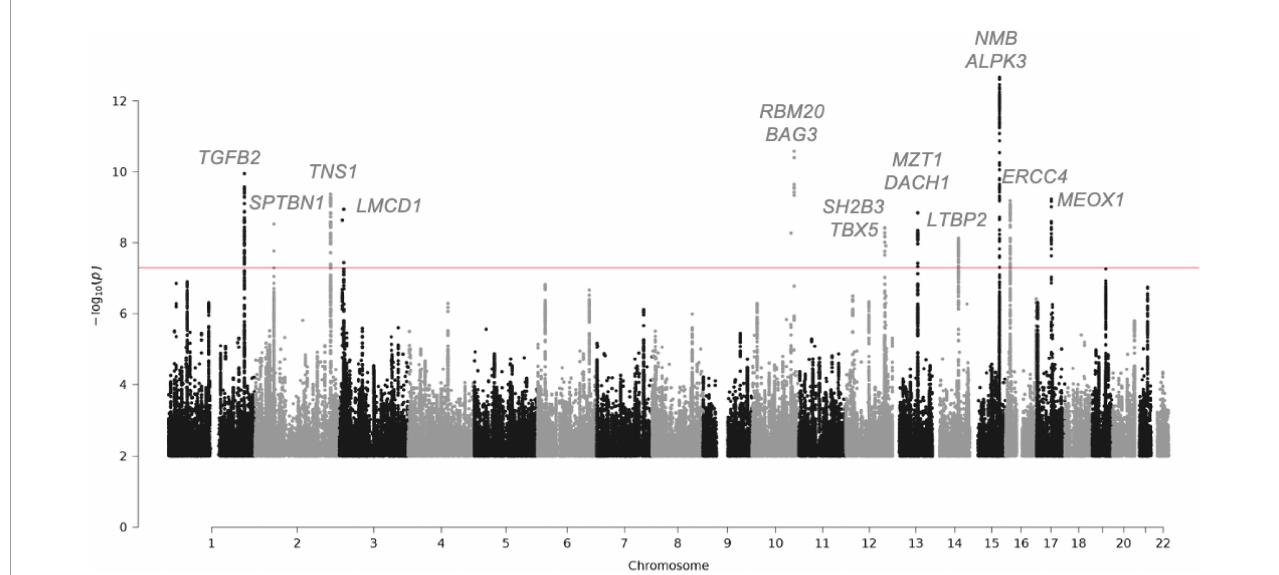
FIGURE2 Manhattan plot showing the loci with genome-wide significance in the mitral valve prolapse meta-analysis and some candidate genes. Fourteen loci reached genome-wide significance ( P -value, 5 × 10-8). Of the candidate genes from the meta-analysis, 15 genes are highlighted. The red line indicates the genome-wide significance cut-off. For the complete list of candidate genes, see Table 2